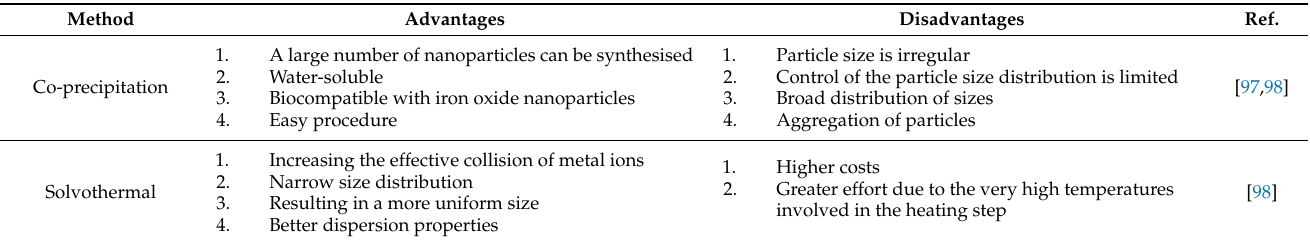
Table 3. R é sum é of advantages and disadvantages of techniques for the magnetic preparation of